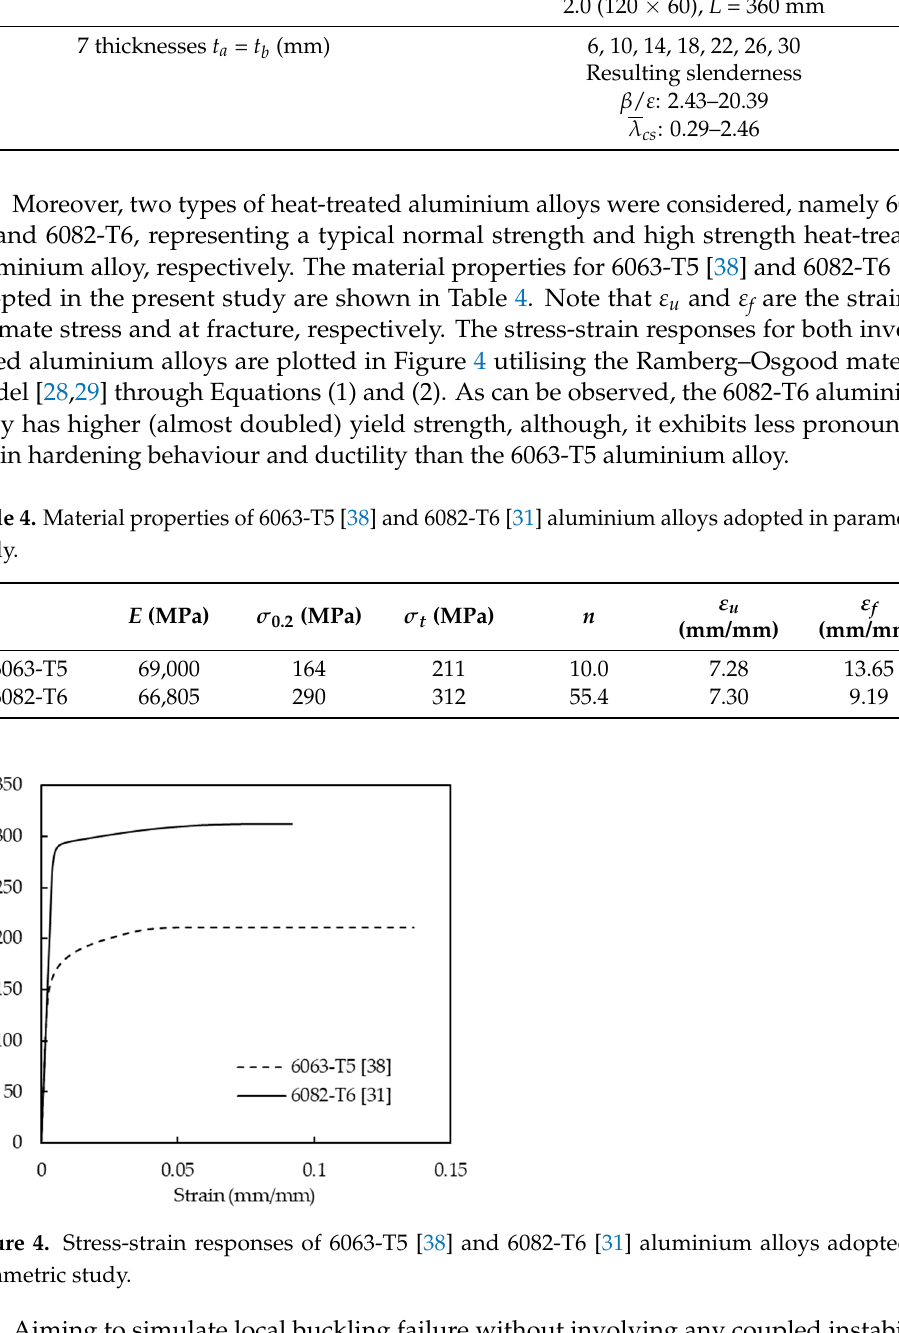
Table 3. List of examined parameters in parametric studies.